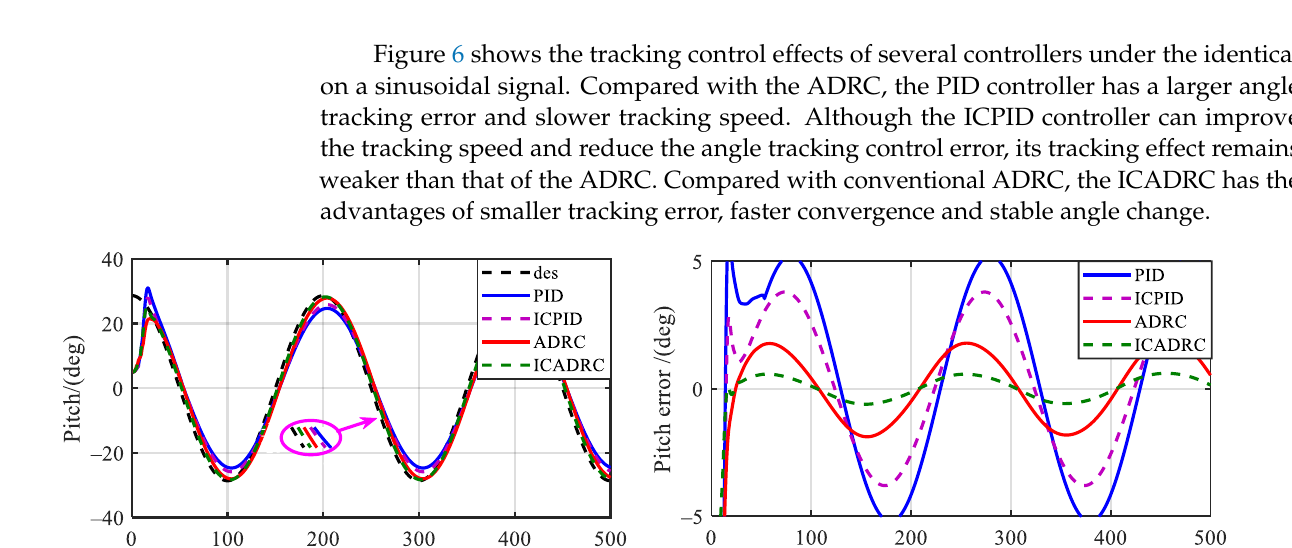
Figure 6. Pitch angle tracking control under sinusoidal signal without external interference. ( a ) The tracking control effects of several controllers under the same sinusoidal signal; and ( b ) tracking er- rors of several controllers.